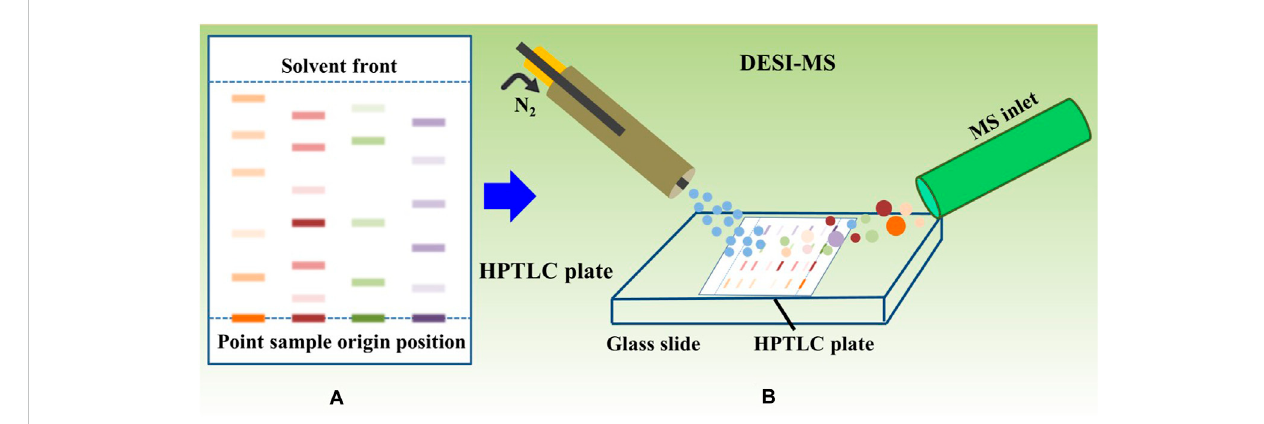
FIGURE 2 Detection schematic diagram of HPTLC-DESI-MSI testing process.